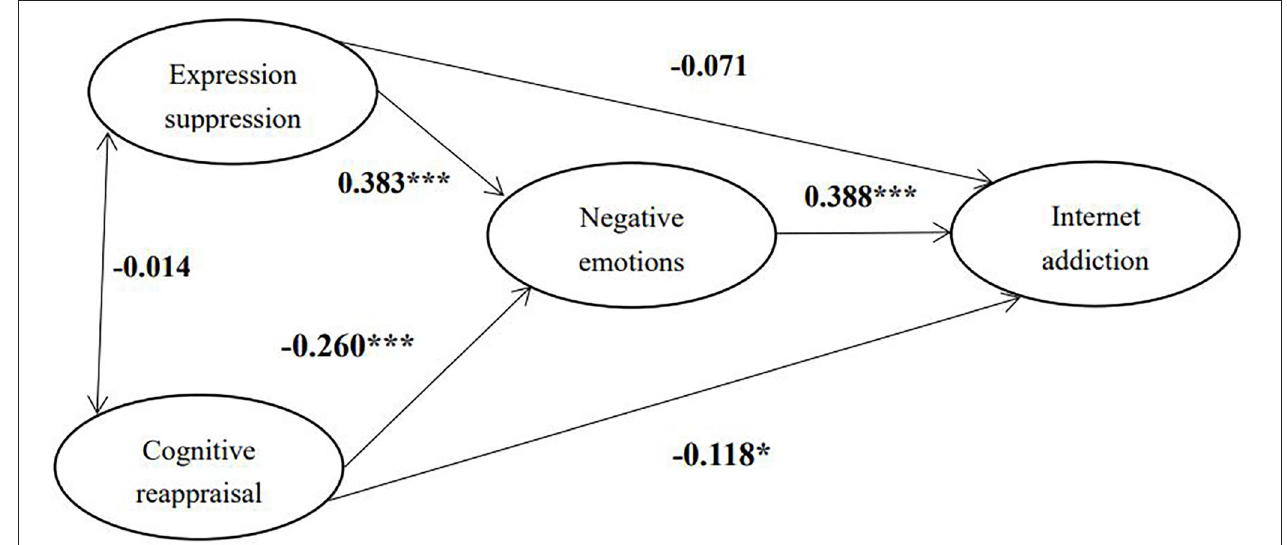
FIGURE 1 | Standardized estimates of the mediated model. * p < 0.05; *** p <